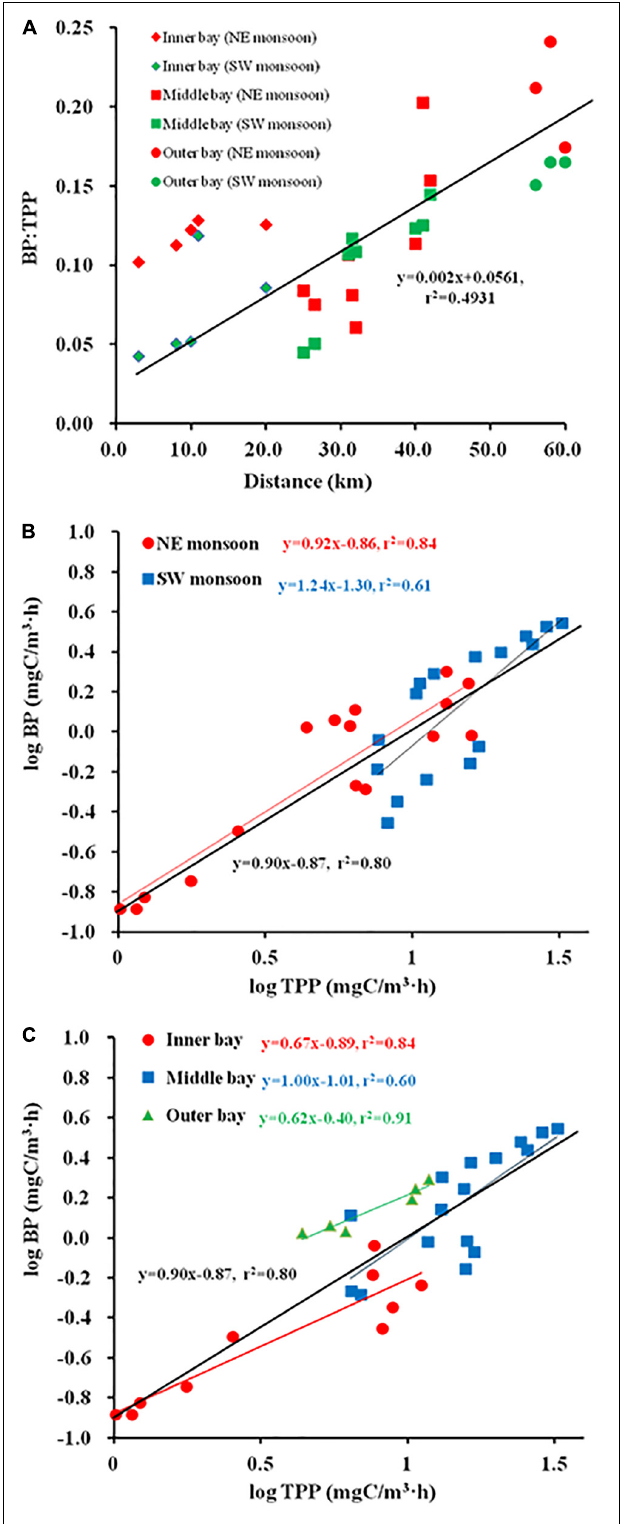
FIGURE 6 | Relationship between BP:total primary productivity (TPP) and distance (A) , Regression plots of Log (PPOC) vs. Log (PDOC) [ (B) season, (C)